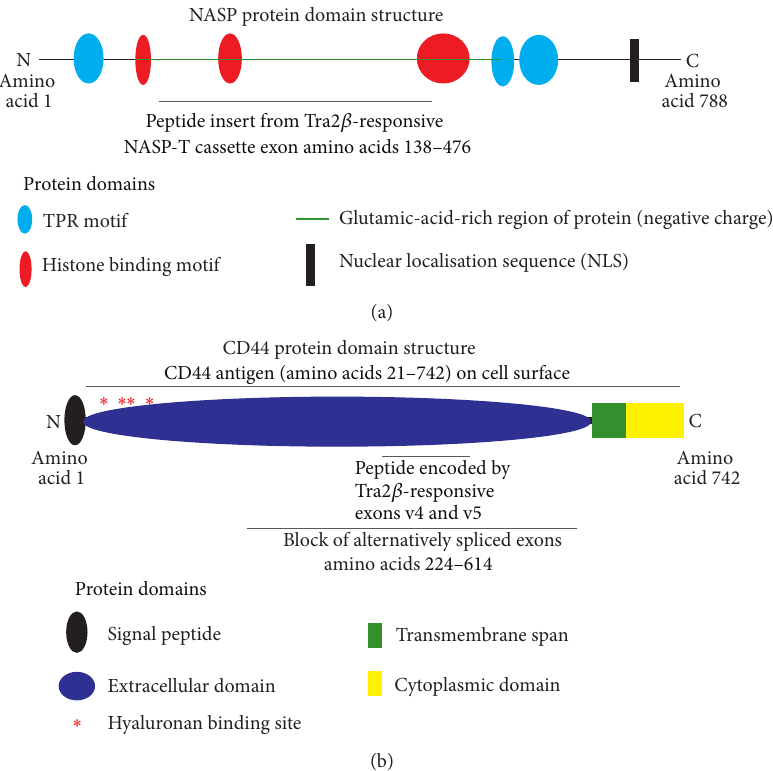
Figure 3: Protein domain architecture of known Tra2 𝛽 splicing targets which are expressed in cancer cells. (a) Modular structure of NASP protein assembled from the UniProt database (http://www.uniprot.org/uniprot/P49321) [46], showing the position of the peptide insert encoded by the Tra2 𝛽 -target exon NASP-T. (b) Modular structure of CD44 protein assembled using information from the UniProt database (http://www.uniprot.org/uniprot/P16070#P16070-6) [46], showing the position of peptide sequences encoded by the Tra2 𝛽 -target exons CD44 v4 and v5. The CD44 antigen is displayed on the cell surface, and the protein is anchored on the cell surface by a single trans-membrane domain. Alternative isoforms are made through alternative splicing of 10 exons out of 19 encoding amino acids in the extracellular domain and also 2 exons which encode peptide sequence in the cytoplasmic domain. The two exons reported CD44 v4 and v5 exons correspond to amino acids 386–428 and 429–472, respectively, in the encoded protein. The protein domain structures are not drawn to